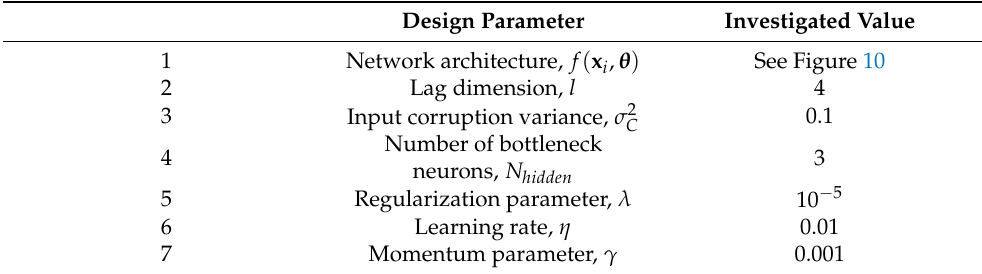
Table 6. AE design parameters.